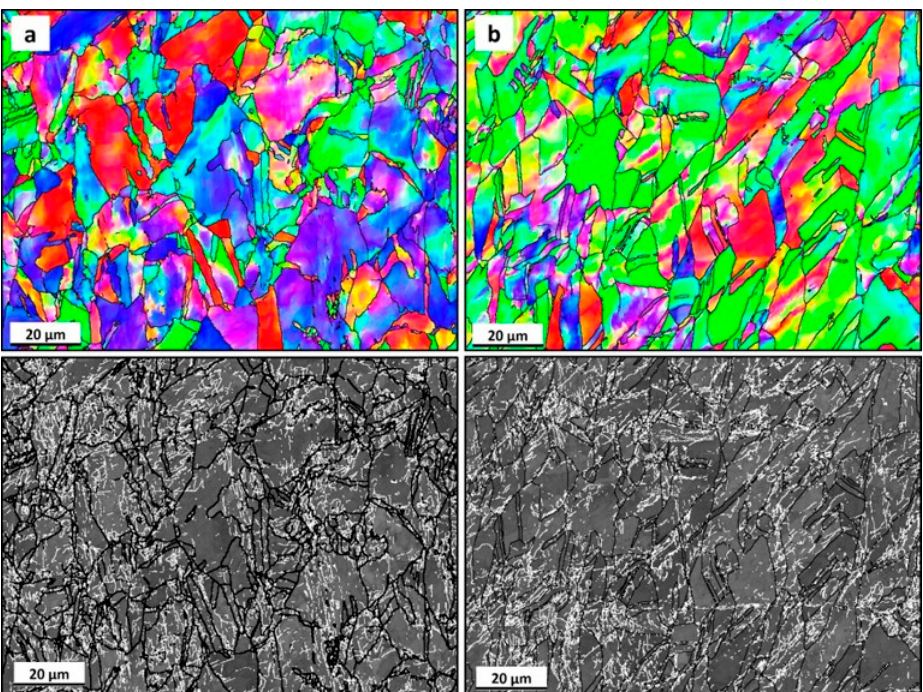
Figure 7. IPF coloring maps relative to ND and their corresponding band contrast maps with the angle boundaries superimposed for the commercial pure Cu ECAP processed at RT for ( a ) 2-P and ( b ) 4-Bc. Step size used in EBSD data collection was 0.2 µm in all cases (for interpretation of the references to color in this figure legend, the reader is referred to the web version of the article).